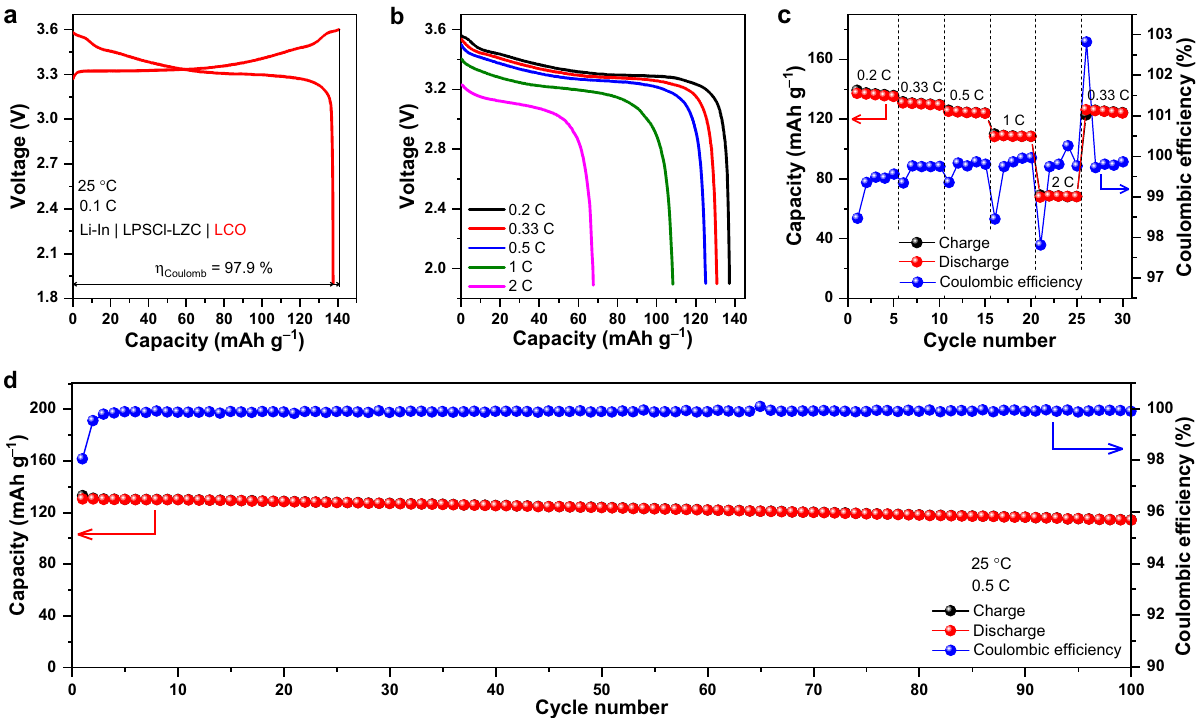
Fig. 5 Electrochemical performance of the Li-In | LPSCl-LZC | LCO cell. a The initial charge/discharge curves at 0.1 C, with the Coulombic ef fi ciency η Coulomb denoted. b , c Rate capability at 0.2, 0.33, 0.5, 1 and 2 C. d Long-term cycling performance at 0.5 C.